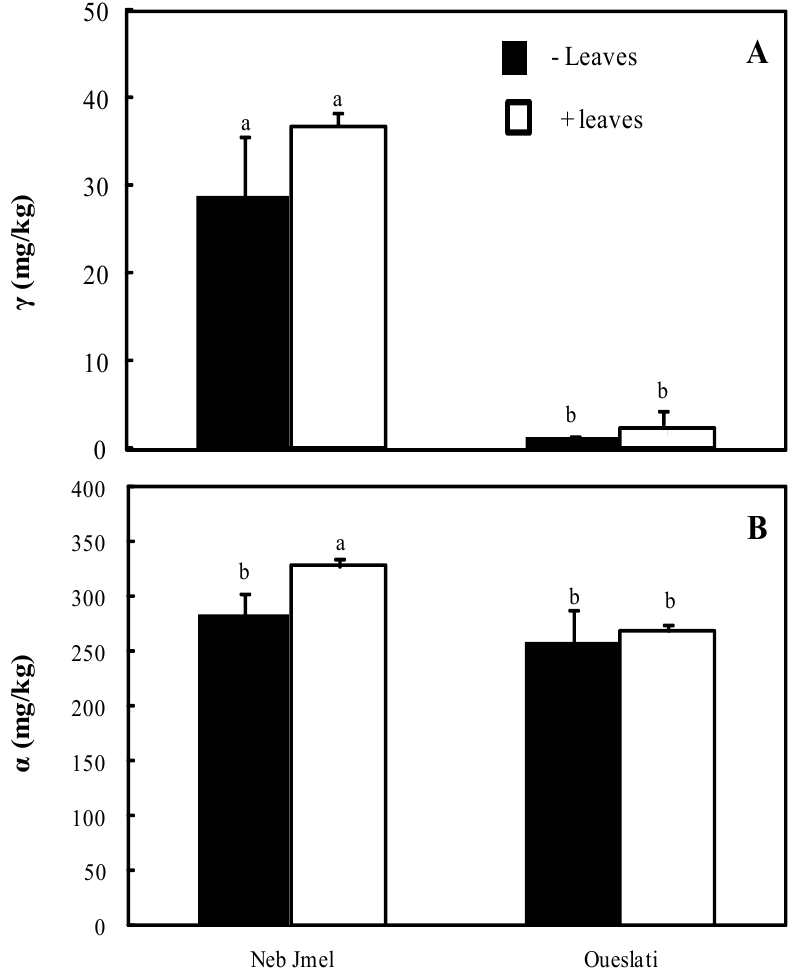
Figure 2. γ -Tocopherol ( A ) and α -tocopherol ( B ) content of Neb Jmel and Oueslati olive oils extracted with and without addition of olive leaves (3%). Data are means of three independent experiments ± SE ( n = 3). Means followed by different letters are significantly different at p ≤ 0.05 as determined by Duncan’s multiple range test.